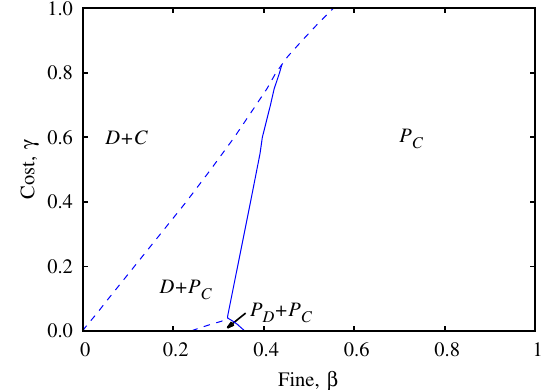
FIG. 1. Full β - γ phase diagram of the spatial public goods game with prosocial and antisocial punishment, as obtained for r ¼ 3 . 8 . Solid lines denote continuous phase transitions, while dashed lines denote discontinuous phase transitions. Two representative cross sections of this phase diagram are presented in Fig.